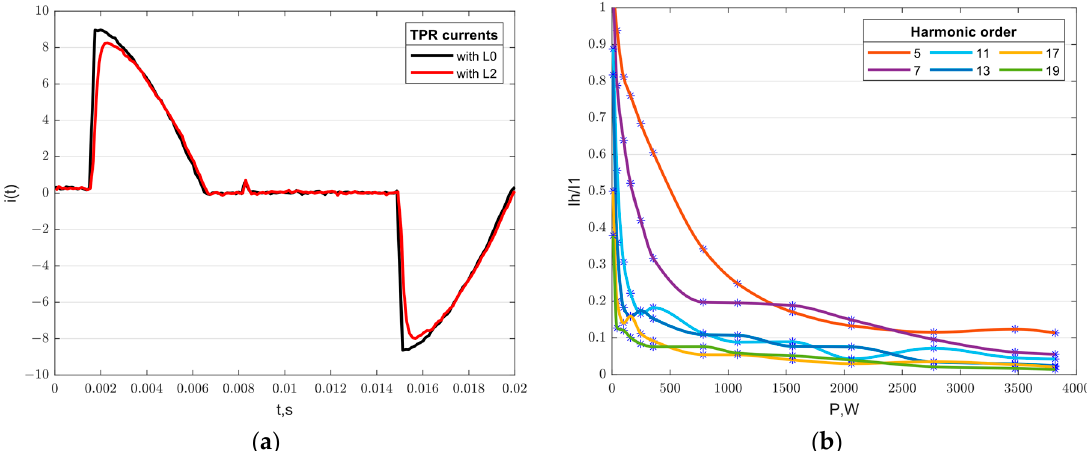
Figure 5. Waveforms of the TPR currents at various values of the grid inductance ( a ); relative values of the TPR harmonic currents for different power consumption ( b ).